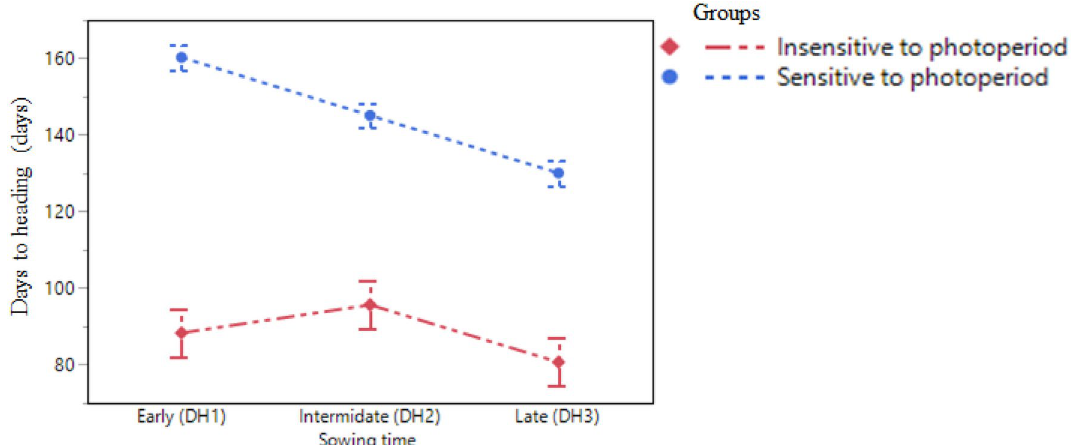
Figure 1. Days to heading of photoperiod-sensitive and insensitive genotypes sown on different dates. Mean (± SE) days to heading of two groups photoperiod-sensitive (PS, blue line, carrying the PPD-D1b allele, Supplementary Table S2) and photoperiod-insensitive (PIS, red line, carrying the PPD-D1a allele, Table S2) for early—8/11/15, intermediate—23/11/15 and late -12/12/15 sowing